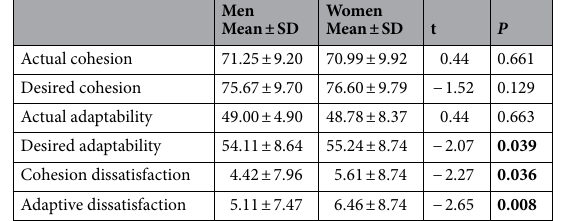
Table 3. The scores for family adaptability and cohesion in infertile couples (N = 508). Significant values are given in bold.